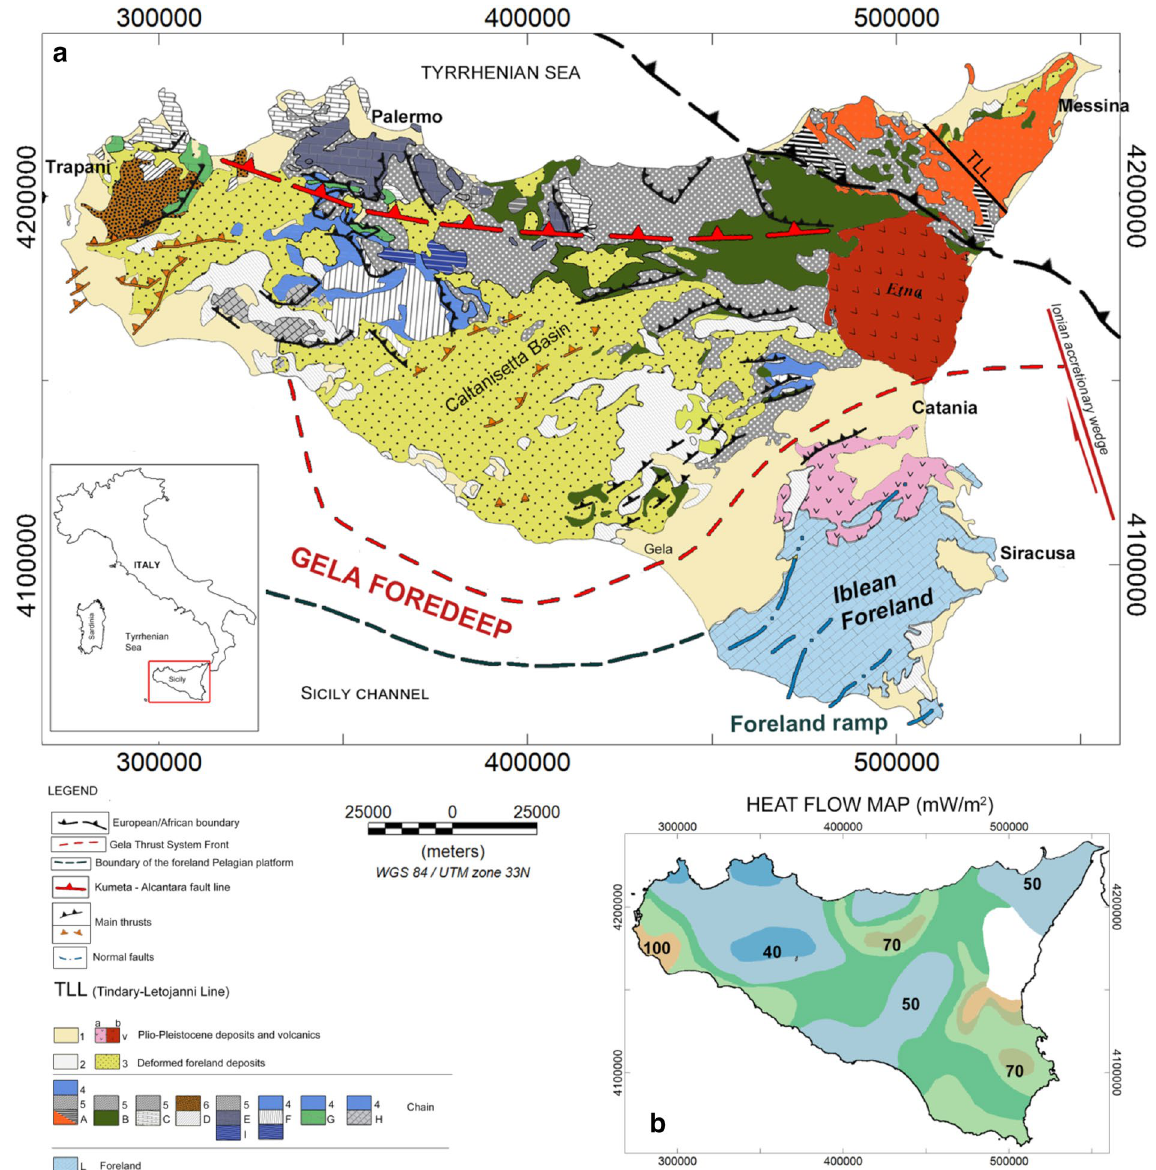
Figure 1. ( a ) Structural-geological map of Sicily [redrawn after 6,10,16,18,19 ]; ( b ) Heat flow map of Sicily [redrawn from 4,7 ]. 1, Pleistocene; 2, deformed foreland basin (Lower Pleistocene–Upper Pliocene); 3, Lower Pliocene– Upper Tortonian wedge top basin deposits (deformed foreland basin); 4, deformed foreland shelf margin (Middle to Lower Miocene); 5, Oligo-Miocene deformed foreland basin flysch units; 6, deformed foreland basin shelf margin (Lower Miocene–Upper Oligocene); A, Calabrian tectonic units (Oligocene–Paleozoic); B, Sicilide units (Oligocene–Upper Mesozoic); C, Panormide carbonate platform-derived tectonic units (Oligocene–Trias); D, pre-Panormide carbonate platform to basin-derived tectonic units (Oligocene–Trias); E, Imerese basin- derived tectonic units (Oligocene–Upper Mesozoic); F, Sicanian basin-derived tectonic units (Oligocene–Upper Mesozoic); G, Trapanese carbonate platform-derived units (Oligocene–Trias); H, Saccense carbonate platform- derived units (Oligocene–Trias); I, Lower Permian–Middle Triassic Lercara allochthons; L, Hyblean Pelagian platform units (Lower Pleistocene–Trias); V, volcanic rocks—( a ) Pliocene, ( b ) Pleistocene. The maps have been produced using the software Oasis Montaj Geosoft (ver. 9.7.1; https ://www.seequ ent.com/produ cts-solut ions/ geoso ft-oasis -monta